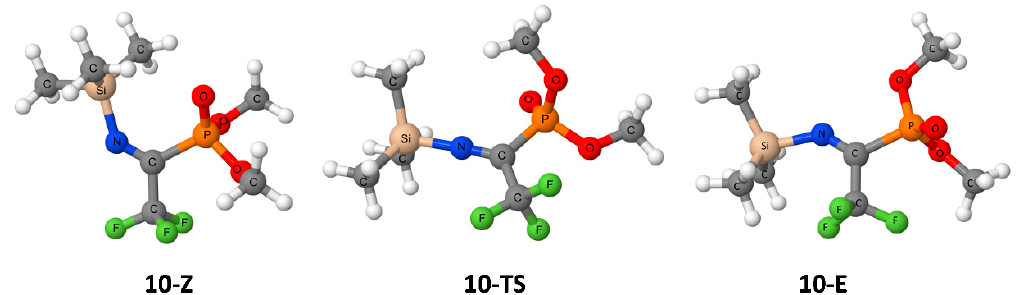
Figure 13. Optimized structures of the Z- and E-isomers of compound 10 ( 10-Z and 10-E , respectively), and the structure